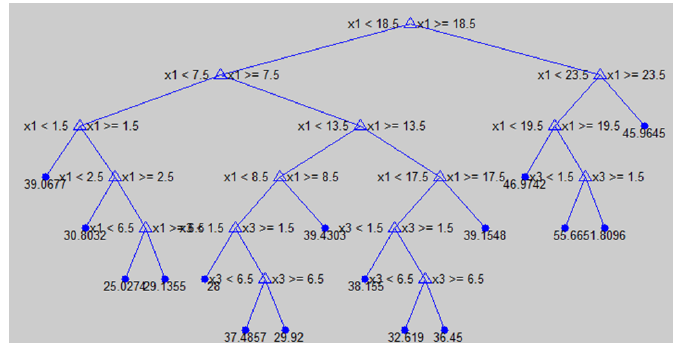
Figure 13. Screenshot of pruned CART tree used for prediction of energy consumption.